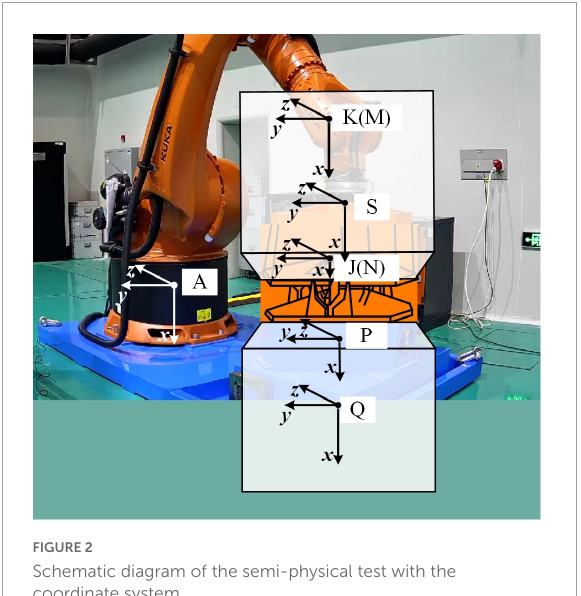
FIGURE2 Schematic diagram of the semi-physical test with the coordinate